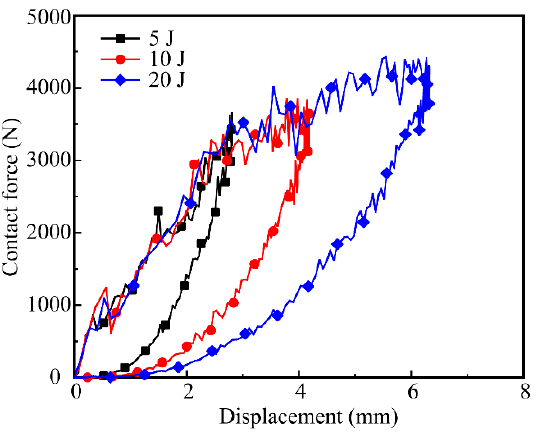
Figure 8. Contact-force–displacement curves for various impact energies.